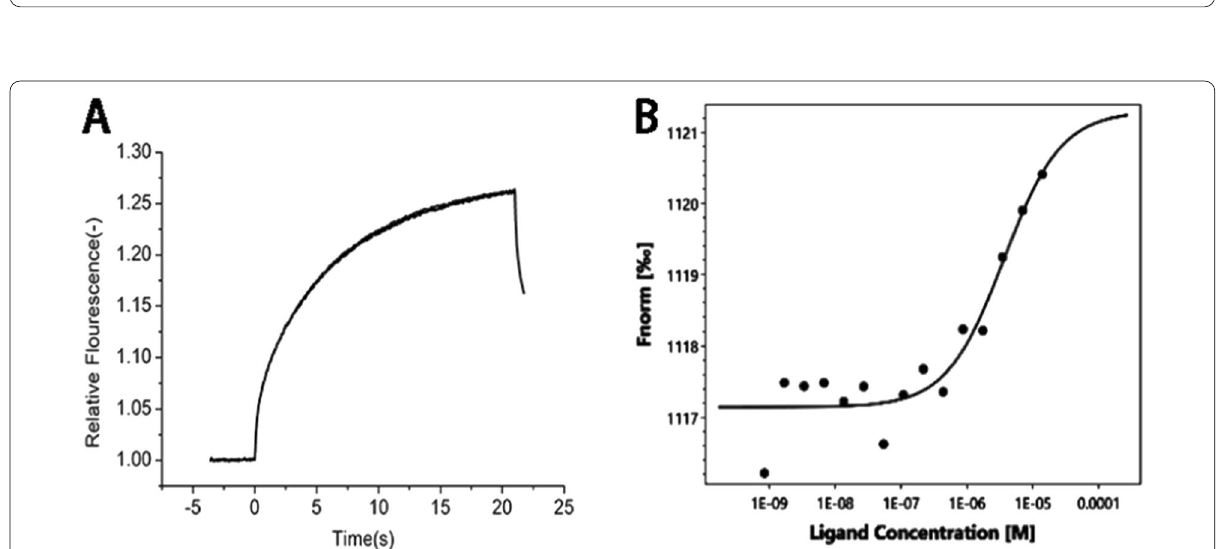
Fig. 7 a Raw MST data. The fluorescently labeled molecules were observed for 5 s. At this time, the infrared laser was turned on, and a small part of the capillary tube was heated to 2–5 °C. The molecules migrated along a thermal gradient, resulting in changes in fluorescence intensity. When the infrared laser is turned off, the molecules diffuse along the concentration gradient. b The binding curve is generated by the difference between the initial fluorescence intensity and the intensity in the presence of heat, and the curve conforms to the standard 1:1 binding